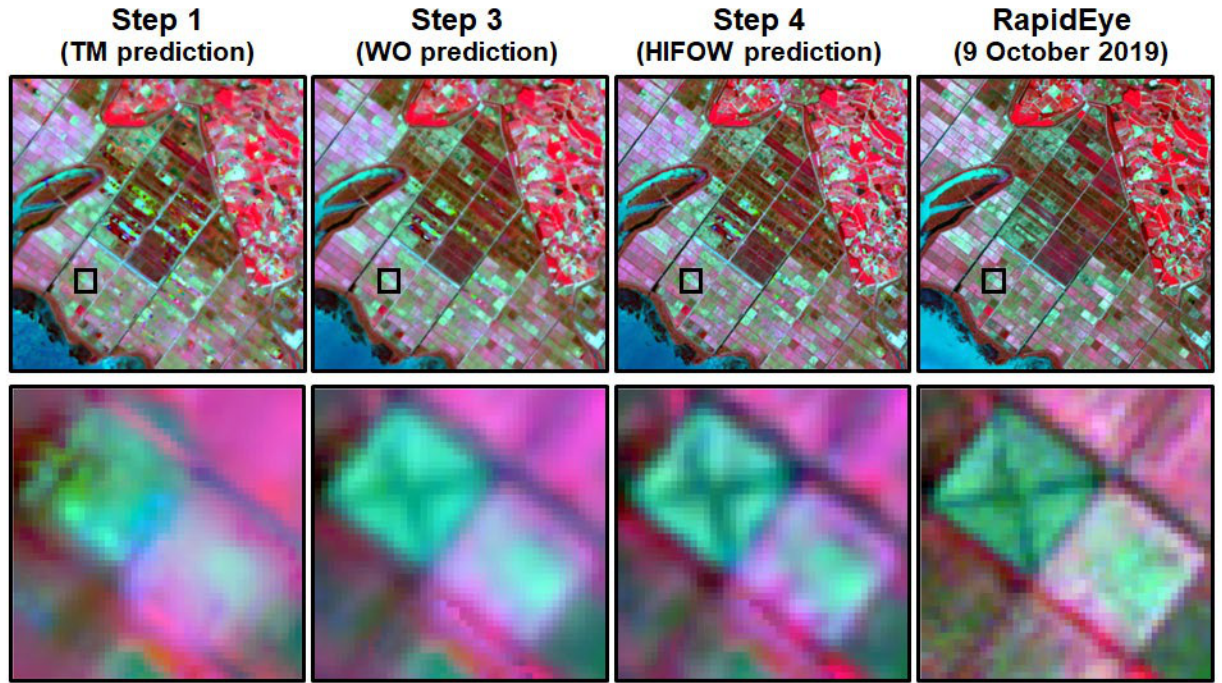
Figure 5. Interim prediction results of HIFOW and actual RapidEye imagery at Site 2 (NIR-red-green as RGB). The black box marked in the first-row imagery is zoomed in the second row.